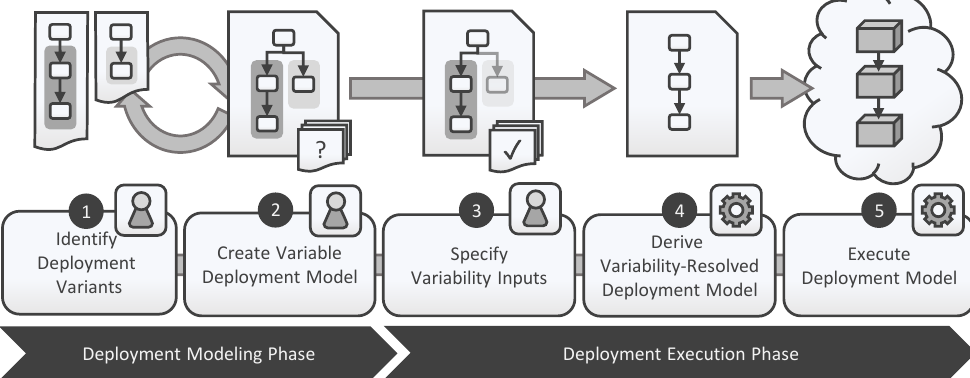
Figure 2. Overview of the Variable Deployment Modeling Method and its five